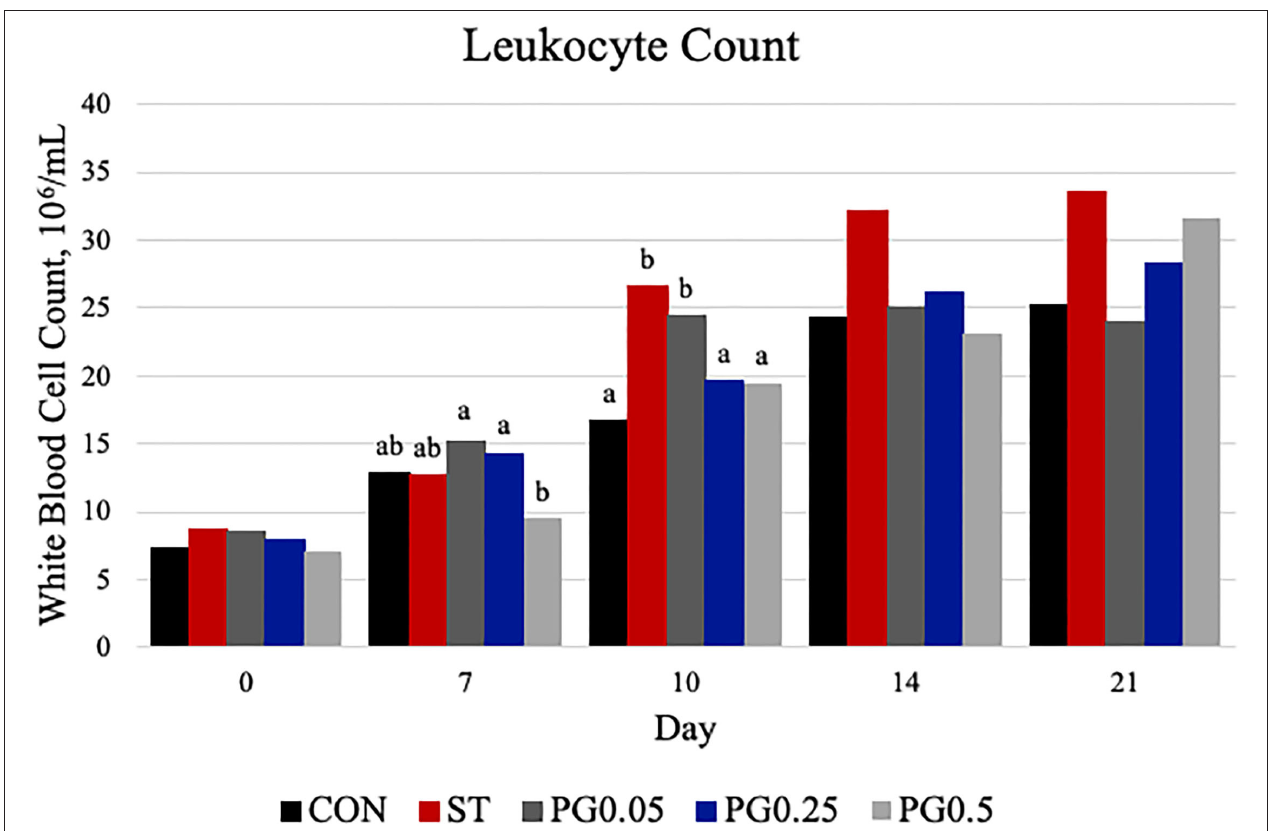
FIGURE 7 | Leukocyte count was measured on days 0, 7, 10, 14, and 21. There was a treatment × time interaction ( P = 0.0074). There were treatment differences on day 7 ( P = 0.0468) and day 10 ( P = 0.0148). On day 7, treatment PG0.5 was decreased when compared to the CON, PG0.05, and PG0.25 treatments ( P ≤ 0.0116). On day 10, the ST and PG0.05 treatments were increased when compared to all other treatments ( P ≤ 0.0247). The largest SEM per time point is expressed as 10 6 /mL and include 1.506, 1.954, 2.959, 3.601, and 4.648 for days 0, 7, 10, 14, and 21, respectively. Bars with different superscripts are statistically different ( P <